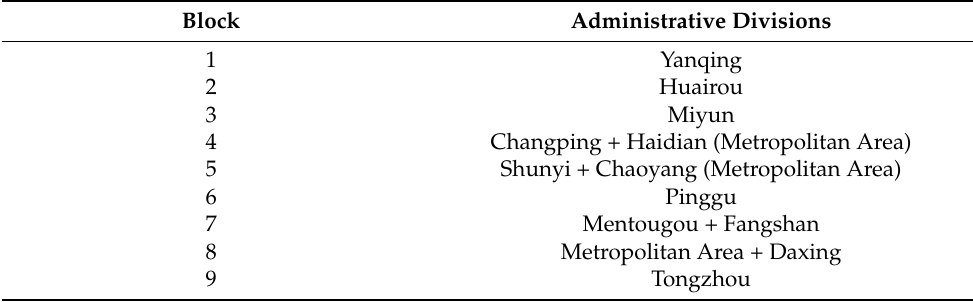
Figure 2. The structure of the multi-convolution neural network.